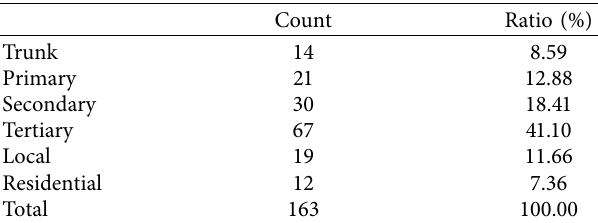
Figure 1: Te study areas and second ring road network. Te red lines, brown lines, and black lines correspond to the second ring road, extension roads directly connected to the second ring road, and linking the extension road of the extension road, respectively. Table 1: Te ranks and the ratio of the sample